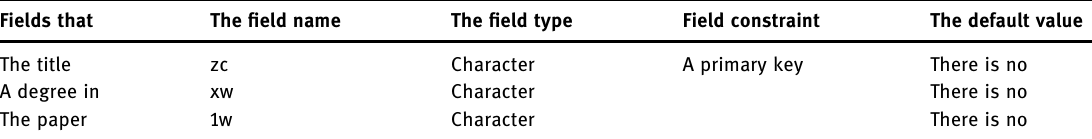
Table 2: Data table of titles, degrees, and published articles Fields